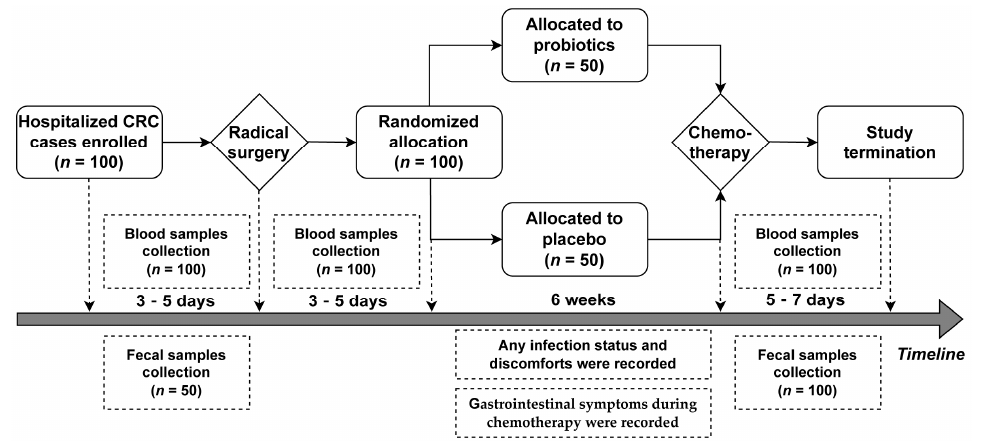
Figure 1. Flow diagram showing the schedule of the